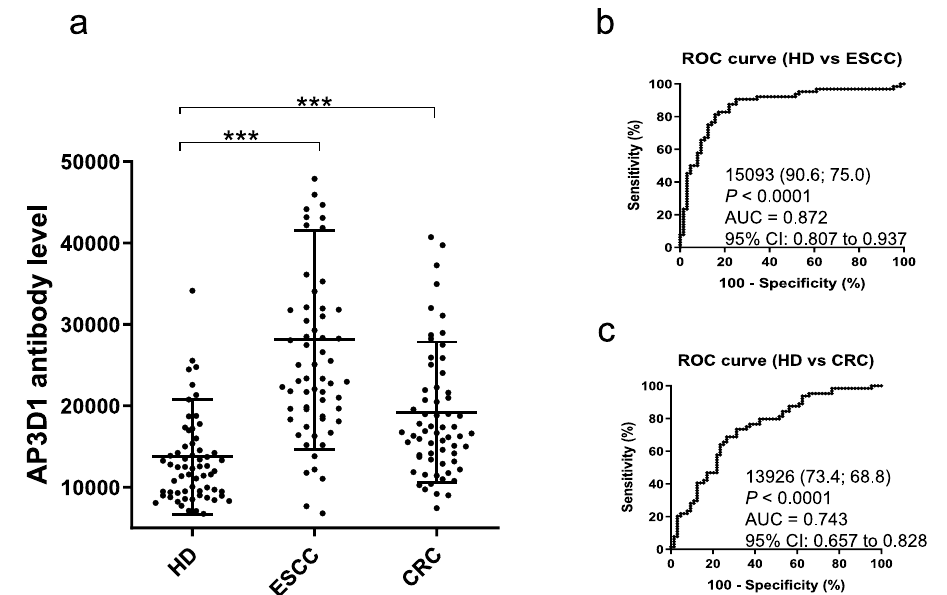
Figure 5. Comparing the serum AP3D1-antibody levels between HDs and patients with digestive organ cancer. This figure shows the ( a ) s-AP3D1-Ab levels in HDs and patients with esophageal squamous cell carcinoma (ESCC) or colorectal carcinoma (CRC) examined using AlphaLISA. The bars represent the average and average ± SD. P -values were calculated using the Kruskal–Wallis test. *** P < 0.001. The data are summarized in Table 5. ROC curves to assess the ability of s-AP3D1-Abs to predict ( b ) ESCC and ( c ) CRC are shown. The numbers in the figures are the same as those shown in Fig. 1. The results of the power calculation were shown in Supplementary Table S3.